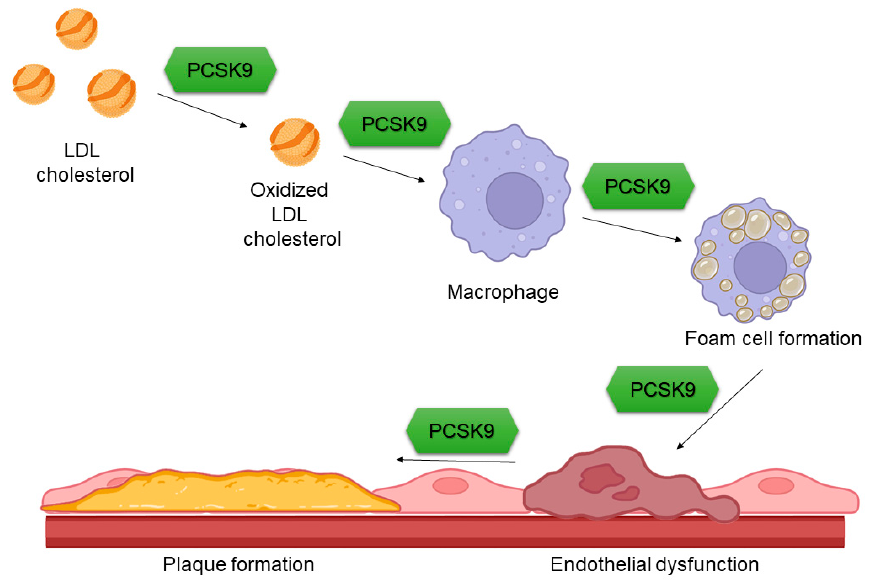
Figure 4. Influence of PCSK9 on arterial wall properties. PCSK9 accelerates the oxidation of LDL cholesterol and the transformation of macrophages into foam cells, resulting in endothelial dysfunc- tion and, consequently, the development of atherosclerotic plaques. PCSK9—proprotein convertase subtilisin/kexin type 9, LDL—low density lipoprotein.